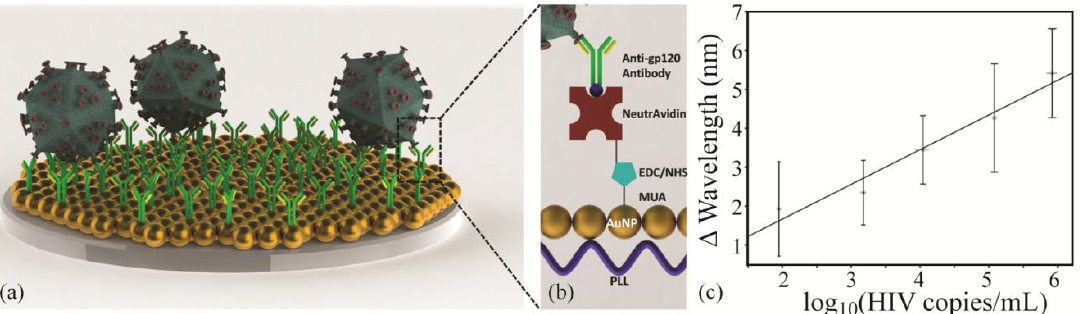
Figure 5. ( a , b ) Schematics showing attachment of antibodies to gold nanoparticles to target specific HIV subtypes using antibodies; ( c ) By monitoring shifts in the excitation peak wavelength, HIV virus subtypeB can be detected from whole blood samples. Adapted with permission from reference [113] © 2013 American Chemical